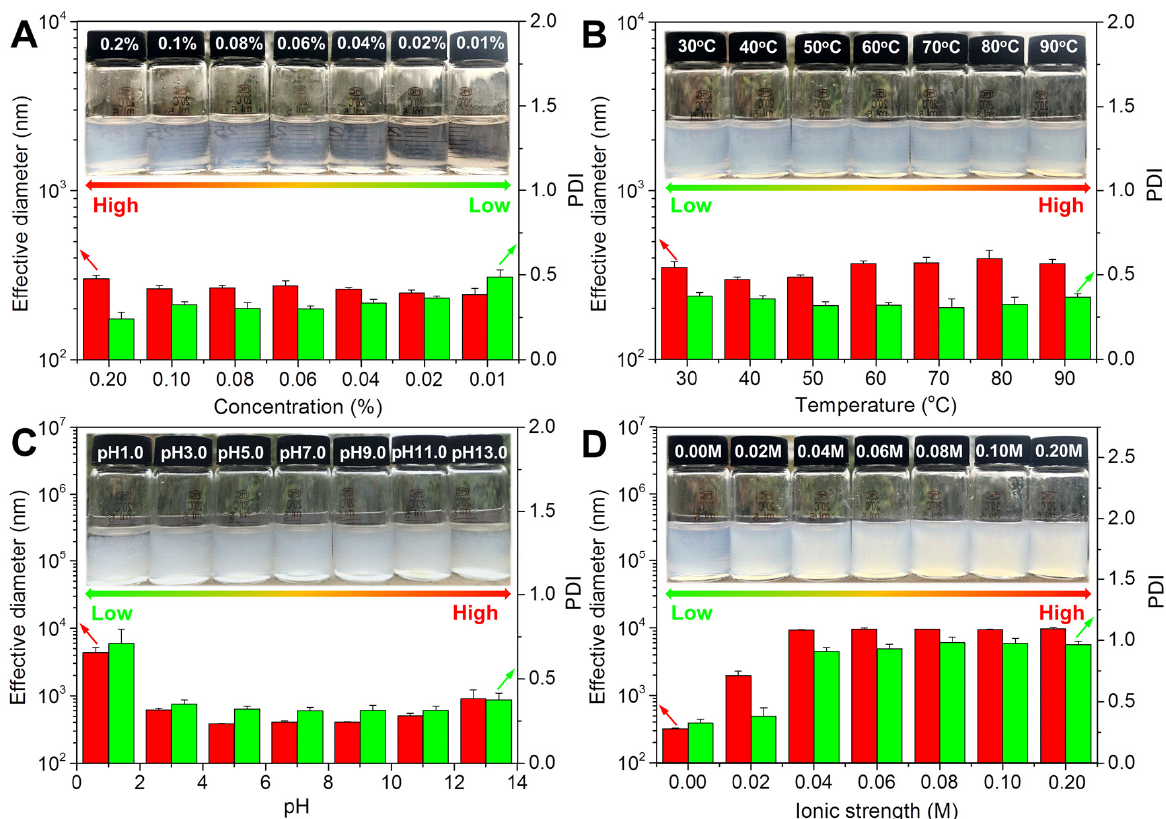
Figure 2. Effective diameter and PDI of nano chitin prepared from Hericium erinaceus residue at different concentrations ( A ), temperatures ( B ), pH values ( C ), and ionic strengths ( D ).